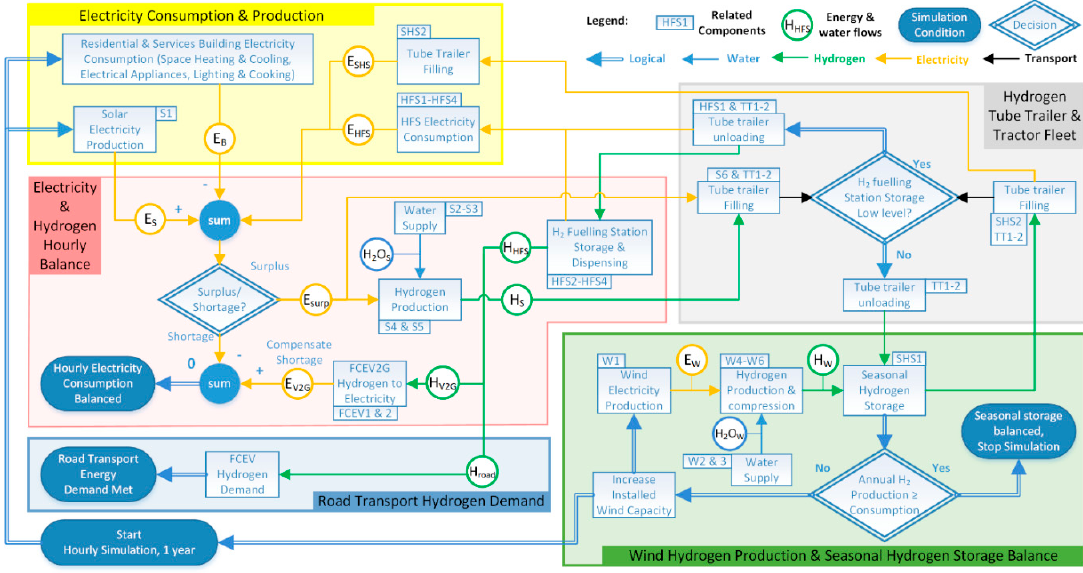
Figure 3. Simplified hourly simulation scheme.